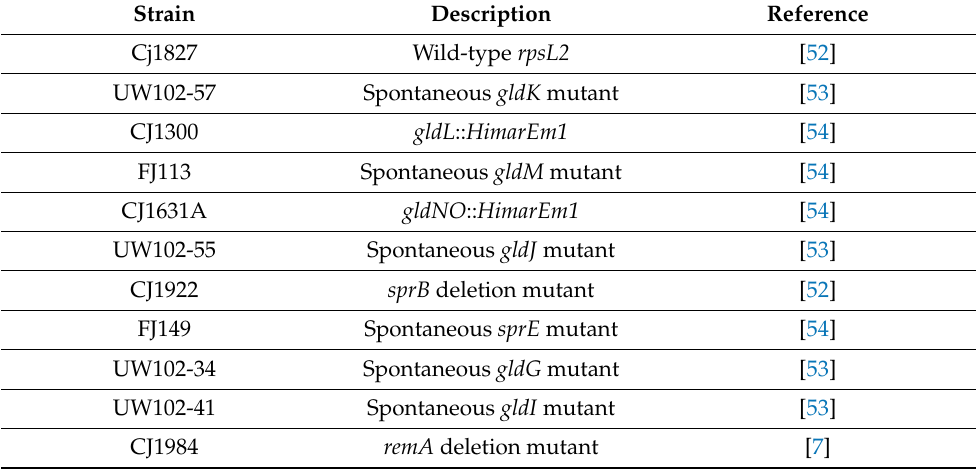
Table 1. Strains used in this study. Strain Description Reference Cj1827 Wild-type